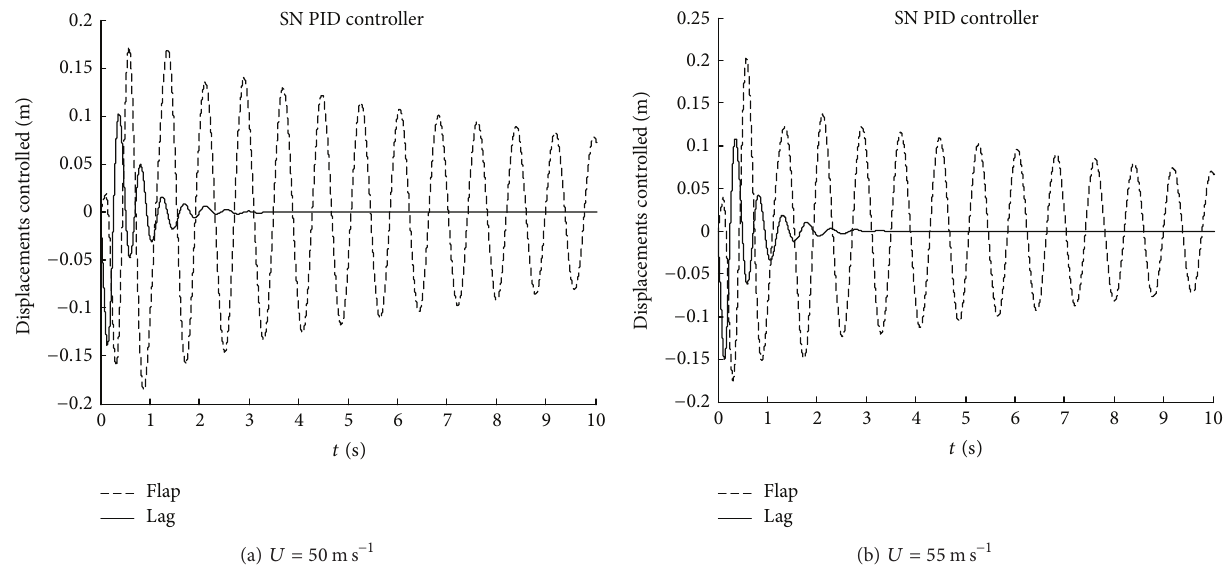
Figure 14: Flap and lag displacements of SN PID control for 𝑈 = 50 ms −1 and 𝑈 = 55 m s −1 , respectively, with rotating speed Ω = 60 rpm.